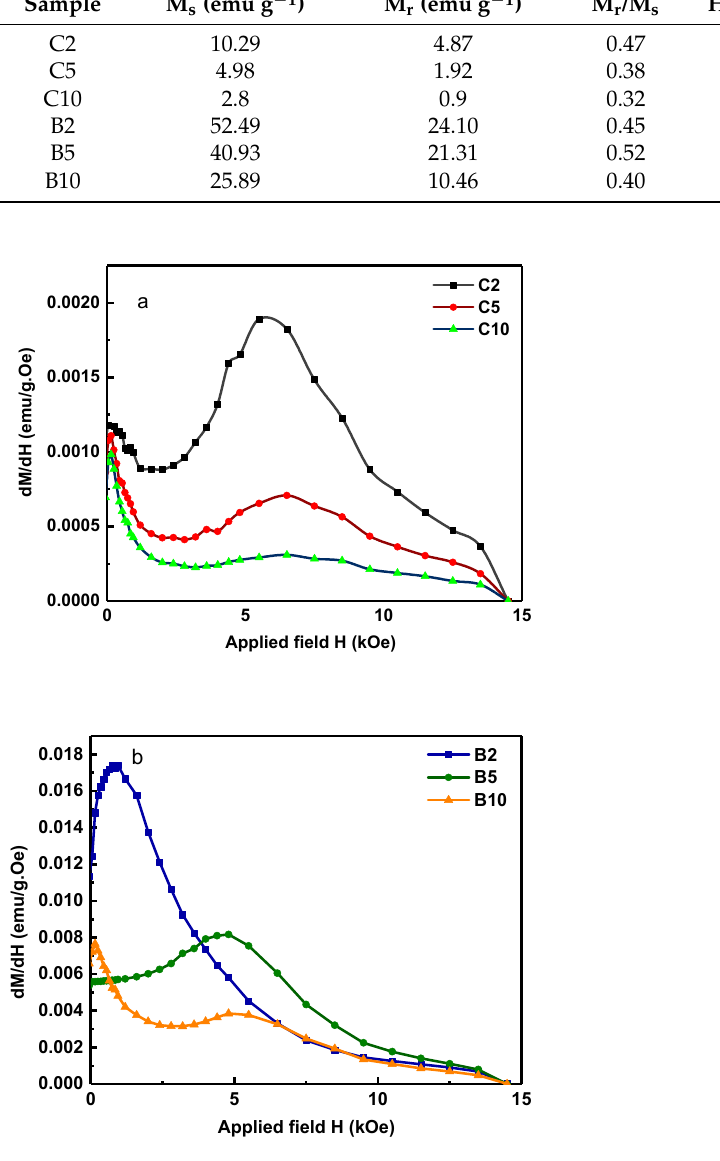
Figure 7. First-order derivative dM/dH of the hysteresis loops for Mn 52 Al 45 . 7 C 2 . 3 samples prepared with the ( a ) cylinder container and ( b ) barrel container at different milling times (t = 2, 5, and 10 h). The coercivity of 3.42 kOe for B5 indicates the magnetic domain’s rotation as the domi- nant demagnetizing mechanism, concluded from the particle’s size. In addition, the defect density reduction inhibits the anti-ferromagnetic coupling between neighboring Mn